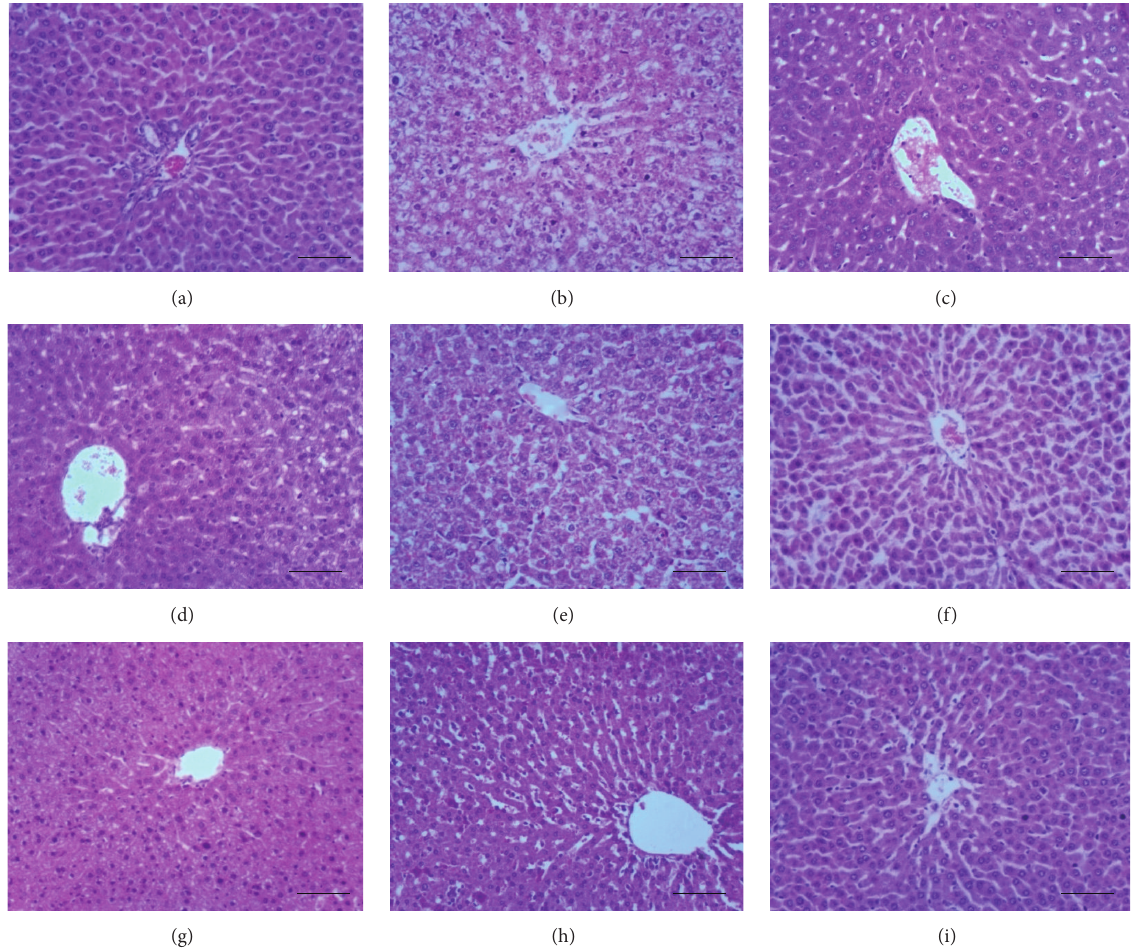
Figure 2: Photomicrograph of liver sections. (a) Normal control: normal polygonal shape of hepatocytes, devoid of cellular injuries. (b) Negative control: it shows fatty change (cytoplasmic halo), slightly edematous tissue section, activated Kupffer cells, and basophilic and pyknotic nuclei of some hepatocytes surrounding the central vein (CV). (c) Positive control: normal hepatocytes with increased eosinophilia, accompanied with mild leucocytosis. (d) 10 mg/kg YL: normal hepatocytes with focal areas of necrosis. (e) 10 mg/kg OL: reduced fatty change as compared to the negative control, with mild oedema. (f) 30 mg/kg YL: section depicts normal cells of the liver, with reduced eosinophilia of cytoplasm of hepatocytes. (g) 30 mg/kg OL extract: focal areas of necrosis with reduced fatty change. (h) 300 mg/kg YL: focal areas of necrosis with mark sinusoidal leucocytosis. (i) 300 mg/kg OL extract: normal hepatocytes with very mild leucocytosis (H&E stain 100x). Bar = 20 𝜇